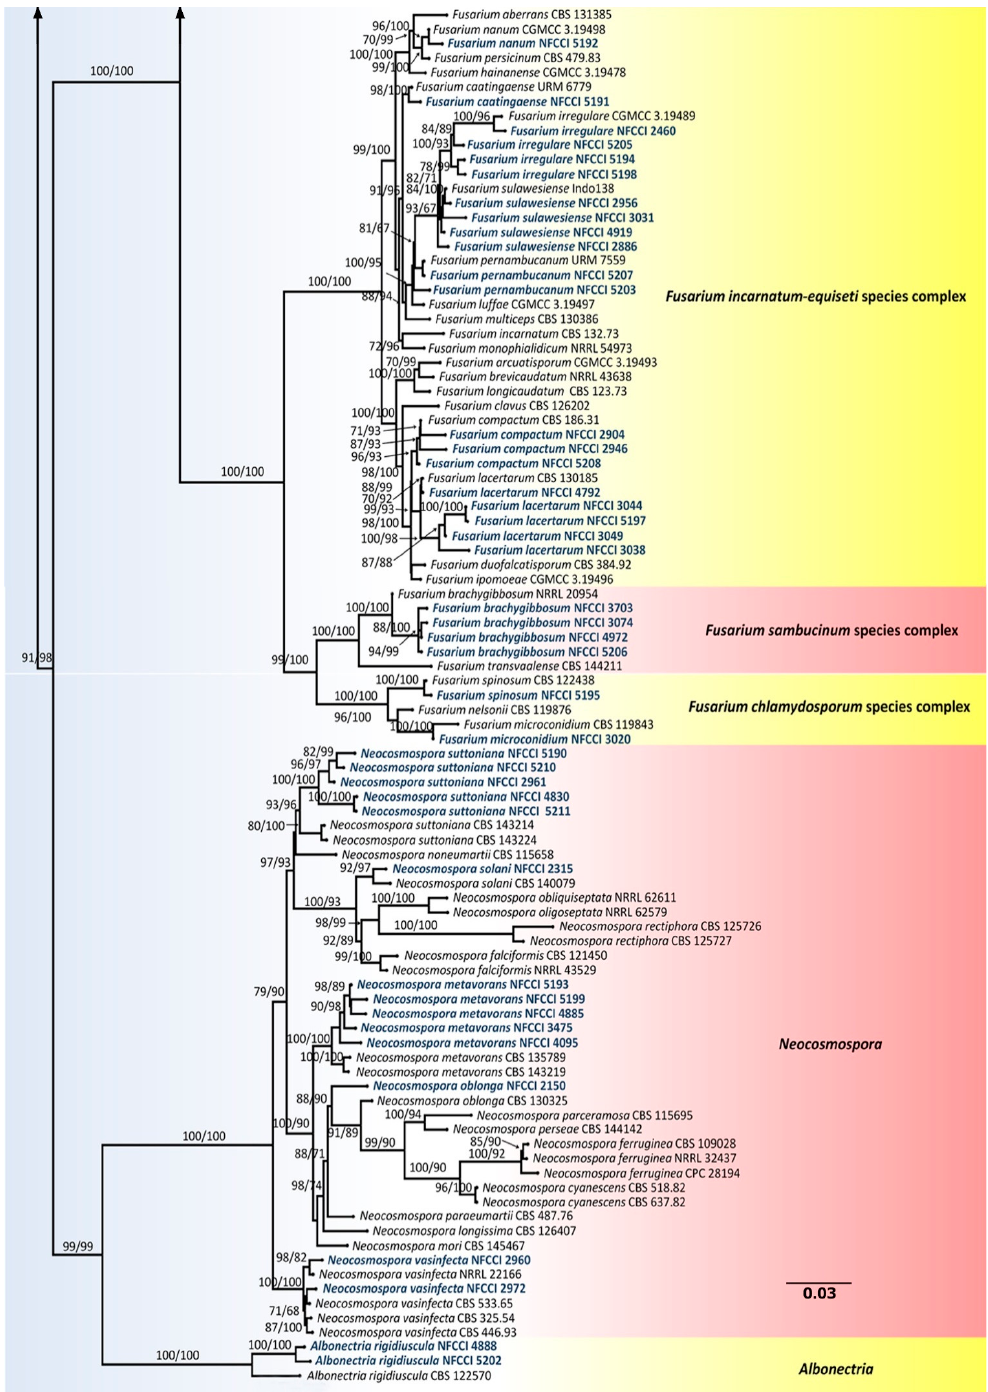
Figure 3. Maximum-likelihood (IQ-TREE-ML) consensus tree inferred from the combined ITS, LSU, Rpb2 , β -tub , CaM and Tef-1 α multiple sequence alignment of genus Fusarium and related genera. Numbers at the branches indicate statistical support values (UFBS and SH-aLRT). The scale bar indicates expected changes per site. The tree is rooted to Atractium stilbaster (CBS 410.67). Isolates used in this study are shown in blue